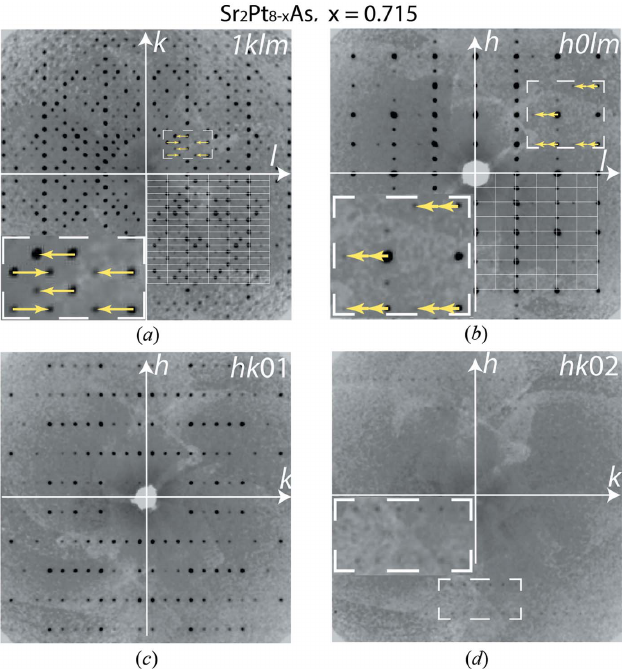
Figure 1 Sections of reciprocal space with main and satellite reflections. The hklm indices correspond to the orthorhombic unit-cell parameters a = 7.95, b = 18.10, c = 5.70 A ˚ and the modulation wavevector q = 0.6038 c * (yellow arrows in insets). In ( a ) and ( b ), the intersections of white lines in the bottom right-hand quarters define strong main hkl 0 reflections; strong satellites of the first order, 1 kl 1, and weak satellites of the second order, h 0 l 2, are away from the intersections. In ( c ) and ( d ), the hk 01 and hk 02 satellites are shown separately. Weak satellites of the second order, hk 02, can be observed only in the areas with low